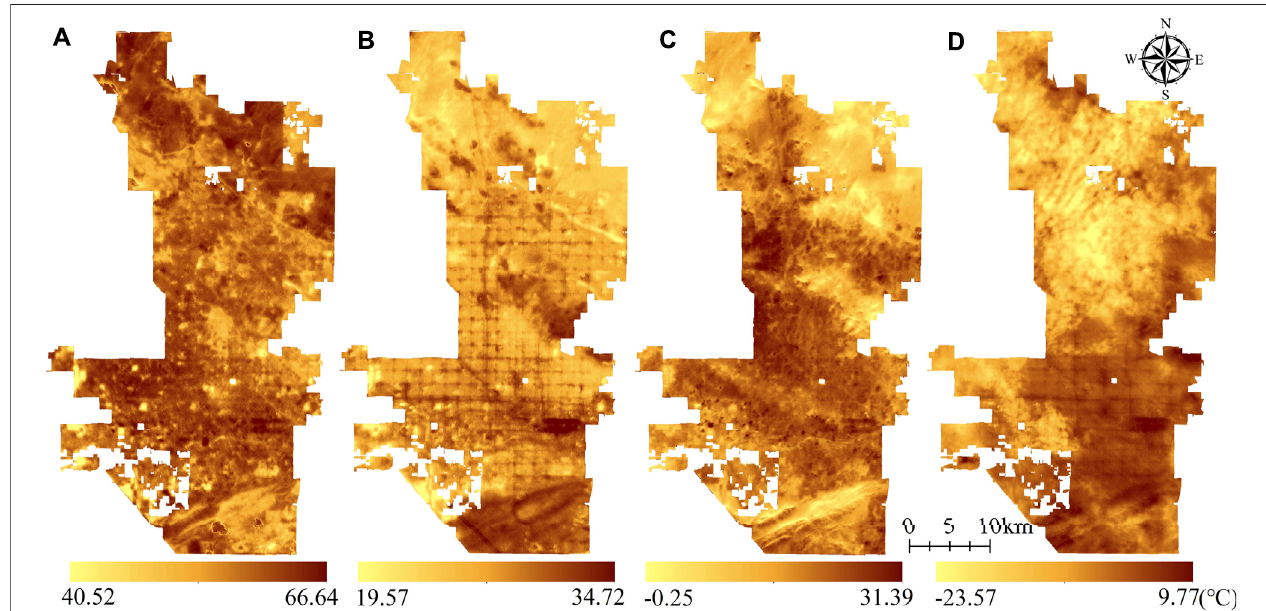
FIGURE 3 | Land surface temperature derived from ECOSTRESS data over Phoenix during (A) summer daytime, (B) summer nighttime, (C) winter daytime, and (D) winter nighttime.